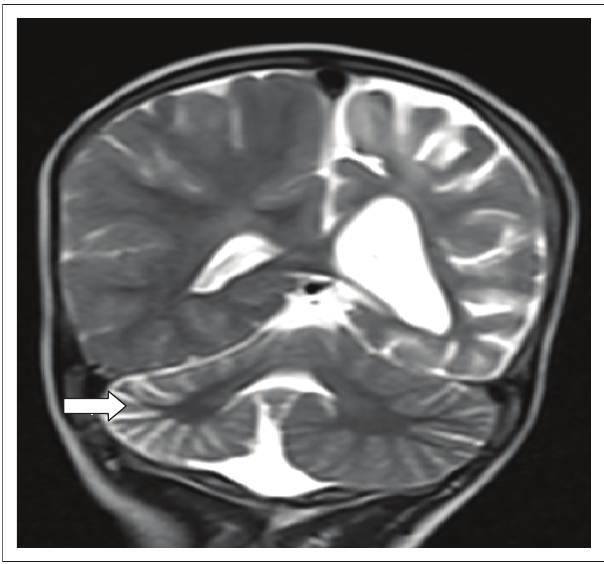
FIGURE 4: Coronal T2 sequence showing gliosis in the left parietal region with left cerebral hemiatrophy, ex-vacuo dilatation of the left lateral ventricle and right cerebellar atrophy (arrow).